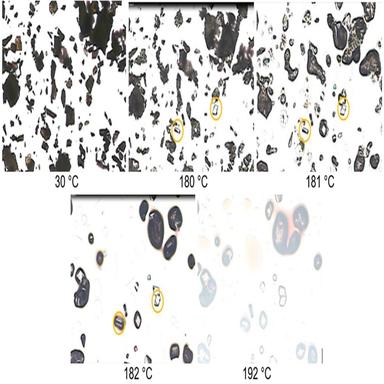
Hot stage microscopy of OLZ sample C, 200×, heating rate of 10 °C.min−1